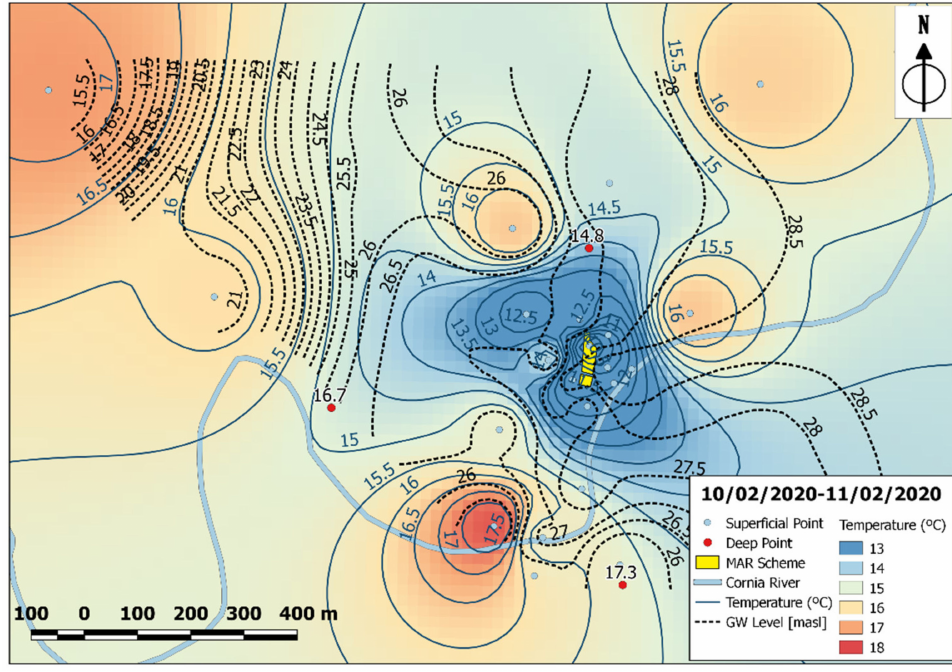
Figure 8. Groundwater temperature distribution with MAR operations halted for the